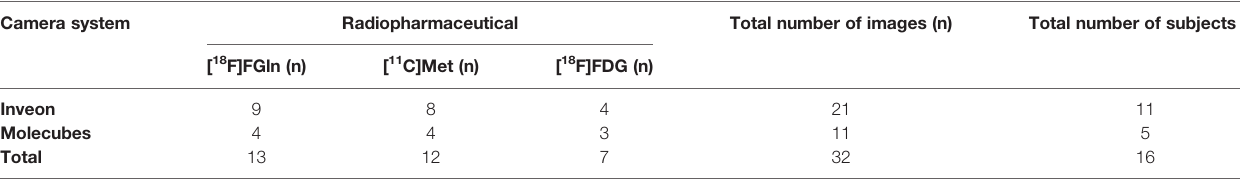
TABLE 1 | Radiopharmaceuticals, imaging systems, and PET/CT image amounts. Camera